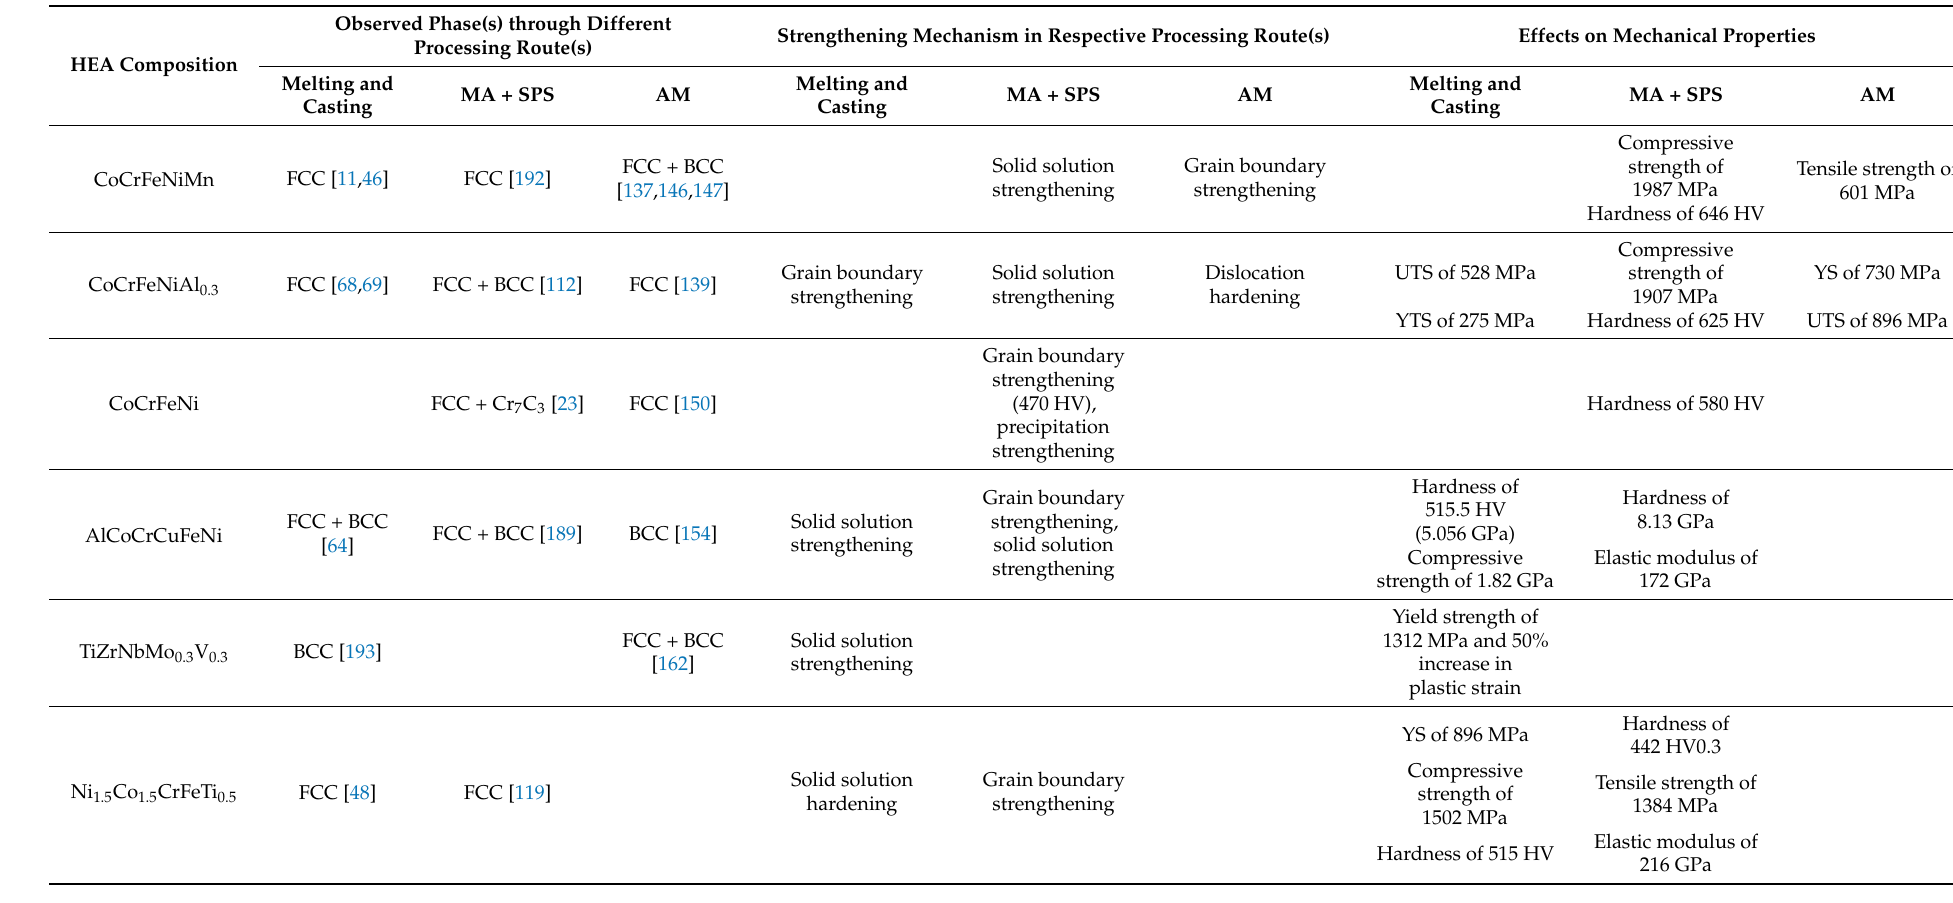
Table 4. Different strengthening mechanisms used to improve the mechanical properties of some HEAs processed by different fabrication